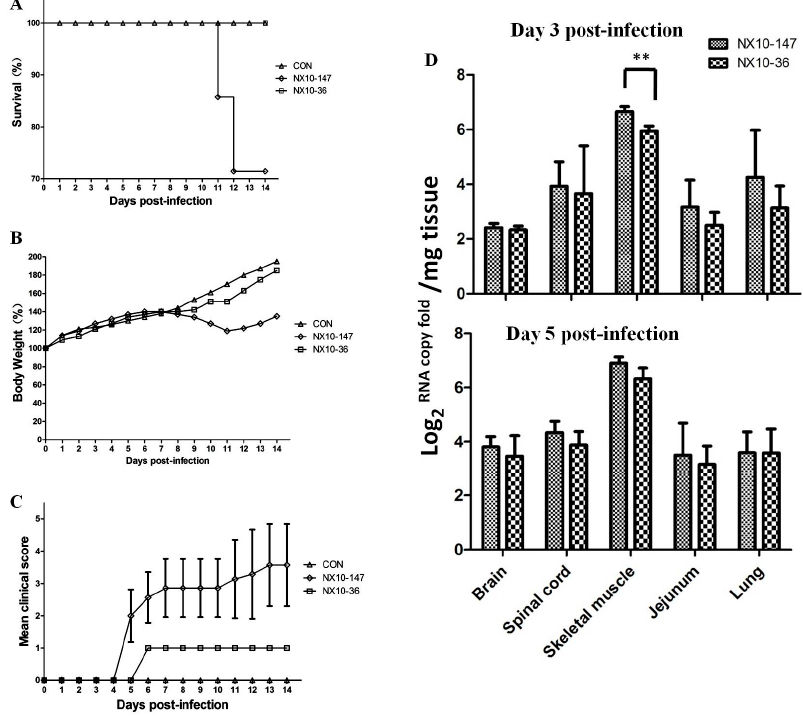
Figure 6. Survival rate, body weight, clinical score, and virus replication in various mouse tissues after the intraperitoneal (i.p.) inoculation challenge with 10 4.5 TCID50 of EV71 NX10-147 and NX10-36 as well as a mock control. Survival rates ( A ), body weight ( B ), and clinical scores ( C ) were monitored daily after challenge. The viral load ( D ) was calculated from a standard curve of quantitative real-time RT-PCR results obtained with 10-fold serial dilutions of the KF444809 virus strain. The data shown here are the mean viral loads ± standard errors (3 mice each). The difference in the viral loads in the skeletal muscle at 3 days post-infection (dpi) were statistically significant by Student’s t -test ( ** p < 0.01).